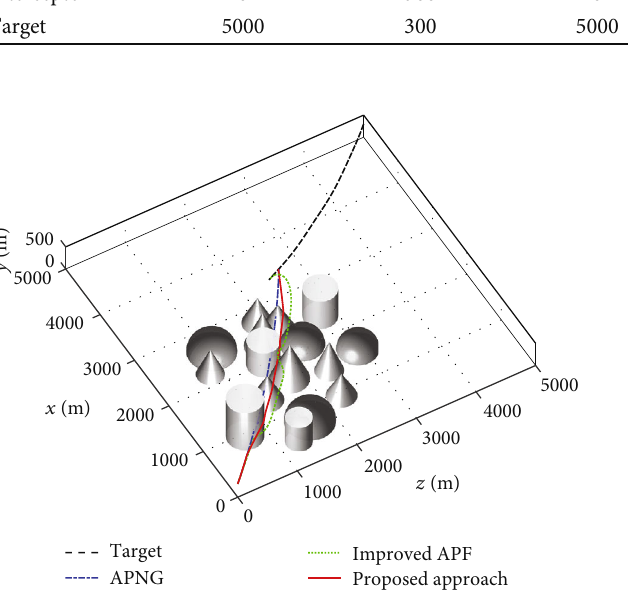
Figure 19: Flight trajectories of interceptor and target in case 4.